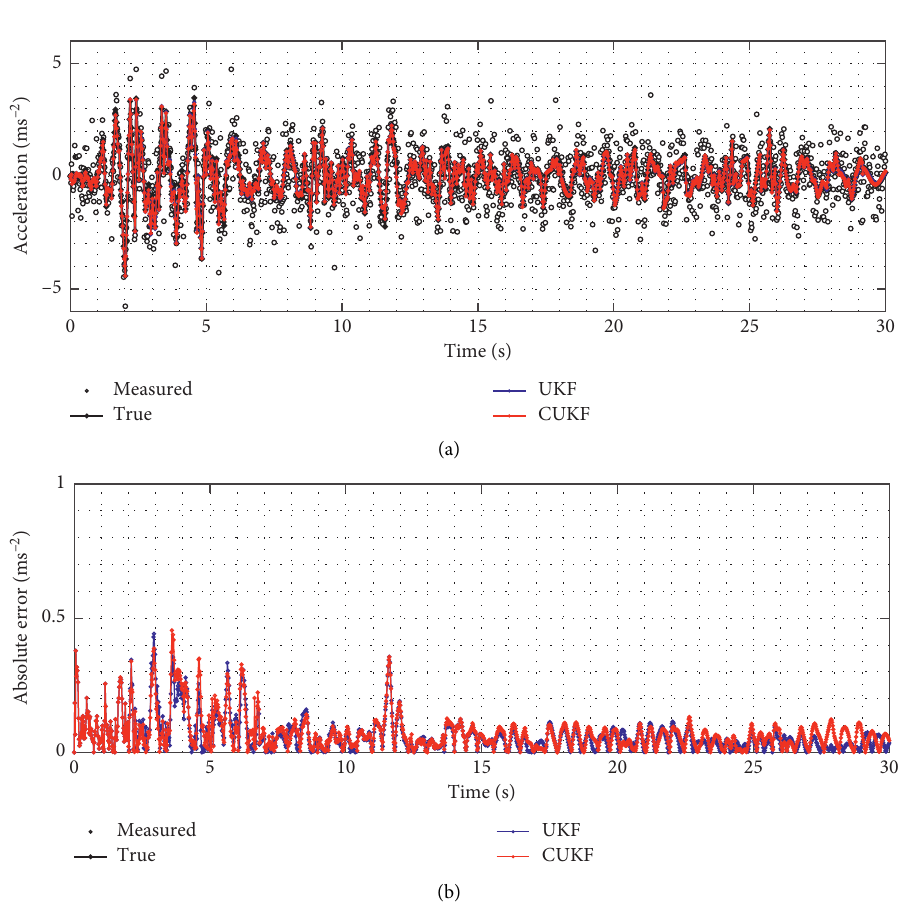
Figure 2: Comparison of acceleration time histories identified by UKF and CUKF (a) and their absolute errors (b) for Example